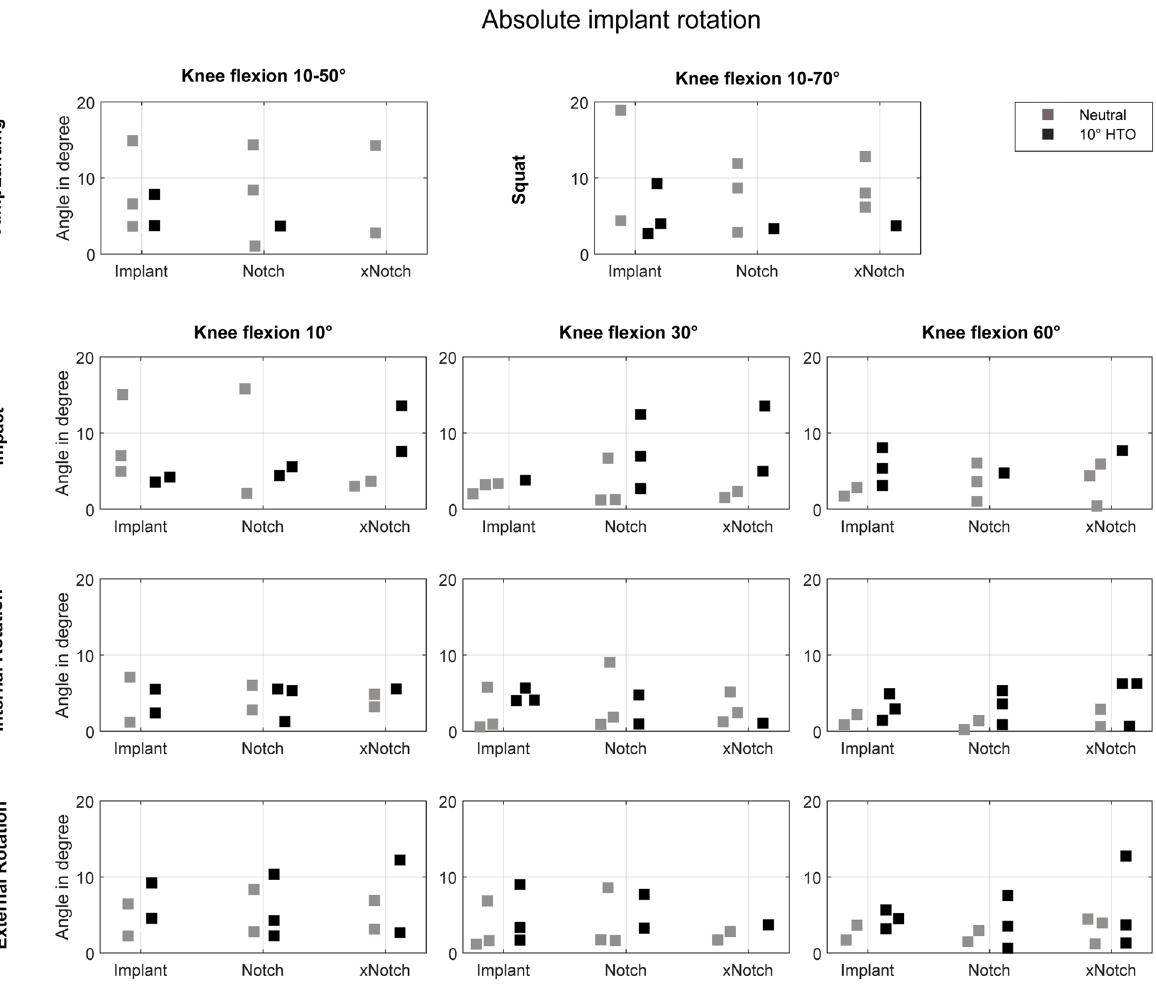
Fig. 6 Maximum absolute rotation in ° of the device during the four different exercises and three different knee states: intact knee joint (inserted device, no notchplasty), conventional notchplasty and extended notchplasty. Coloured distinction between the neutral leg axis position (grey) and the valgus alignment shift